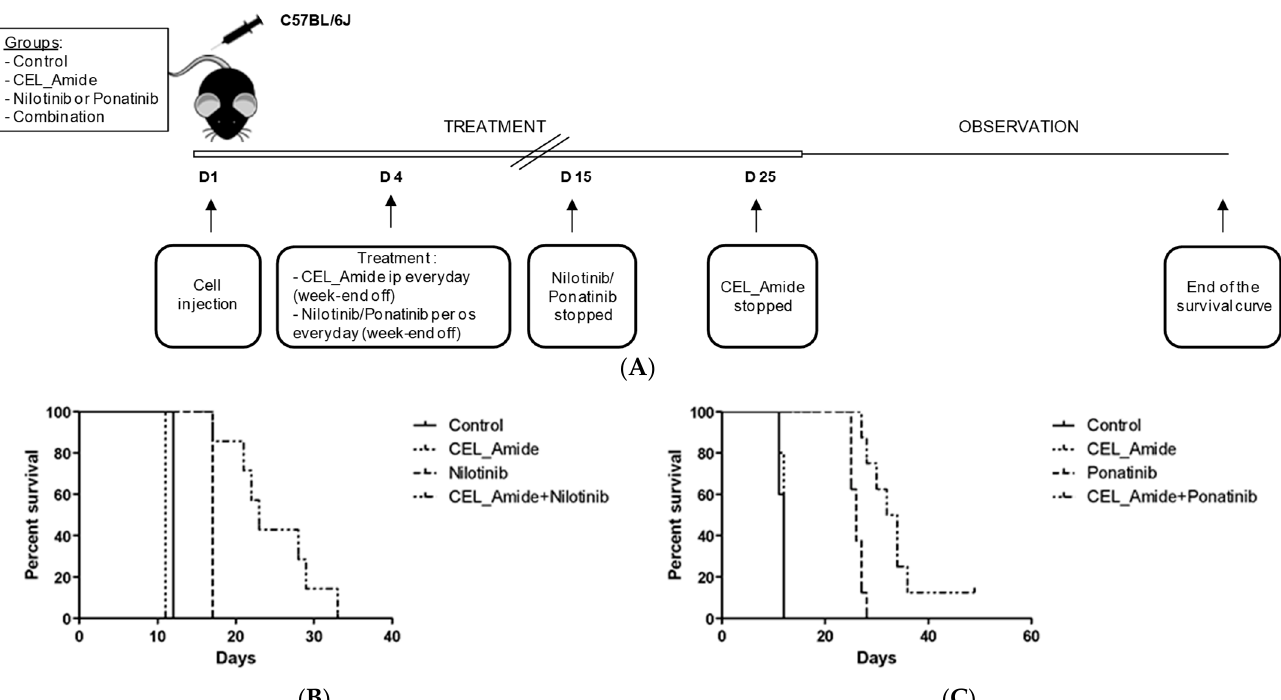
Figure 4. Effects of LIMKi in vivo. To evaluate LIMK1/2 inhibition by CEL_Amide in vivo, C57BL/6J mice were engrafted with GFP+ CDKN2Ako/ BCR::ABL1 + B-ALL mice cells. Mice were treated with vehicle (group 1; n = 5); CEL_Amide alone (group 2; n = 5); nilotinib or ponatinib (group 3; n = 10); or a combination of CEL_Amide and nilotinib or ponatinib (group 4; n = 10) ( A ). Kaplan–Meyer survival curves for mice according to treatment combination of CEL_Amide with nilotinib ( B ). Kaplan–Meyer survival curves for mice according to treatment combination of CEL_Amide with ponatinib ( C ).